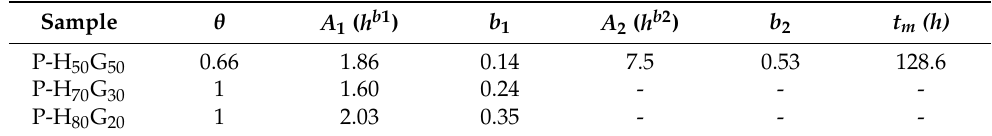
Table 6. Weibull’s model parameters obtained after fitting the release data.